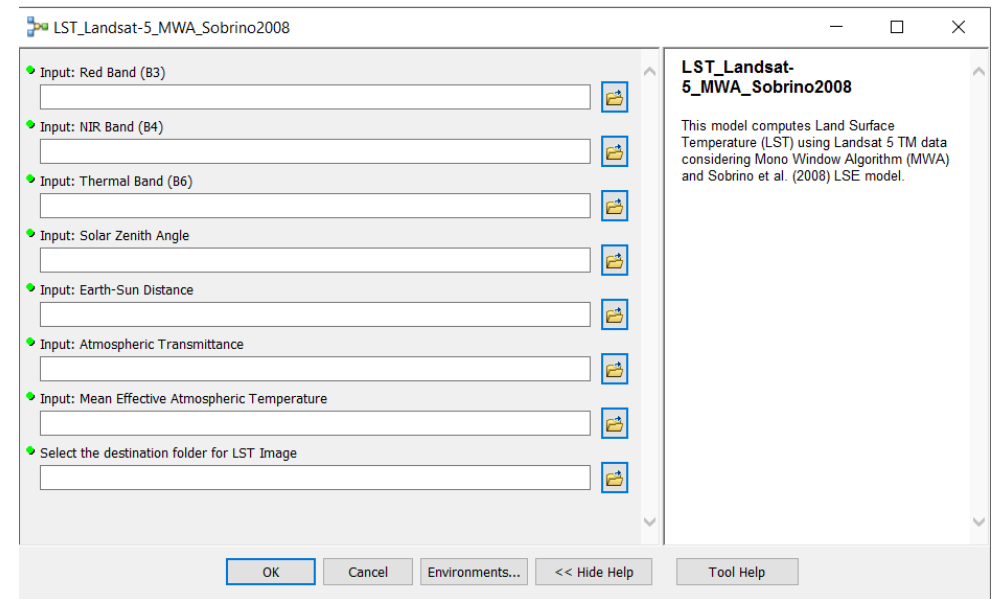
Figure F2. The interface of the MWA method using the Landsat 5 TM data and Sobrino et al.’s LSE model.